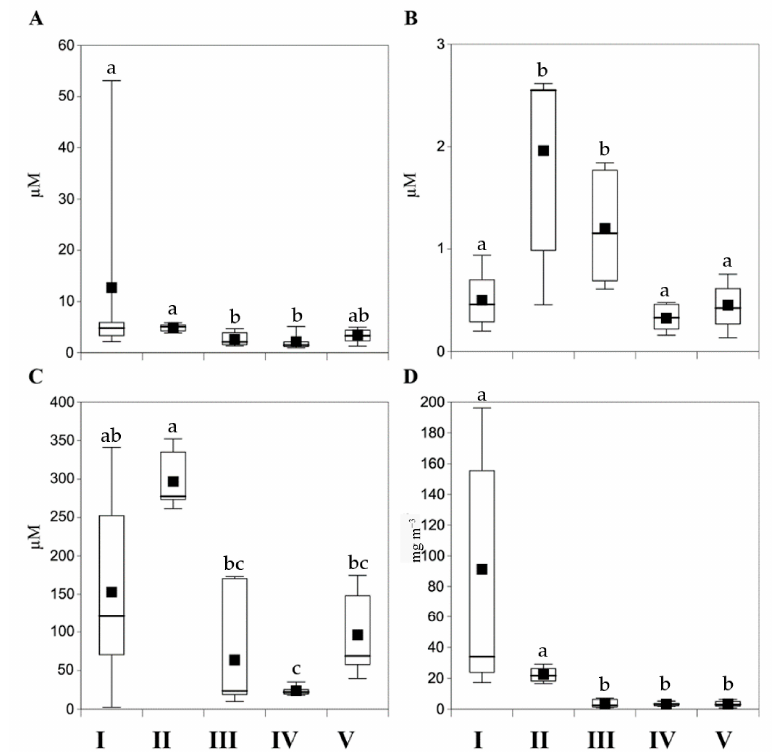
Figure 3. Boxplots depicting seasonal variability of dissolved inorganic nitrogen (DIN) ( A ) reactive phosphorus (PO 4 ) ( B ), reactive silica (SiO 4 ) ( C ), and chlorophyll a (Chla) ( D ) in Santa Giusta Lagoon along the study periods. Five periods were considered: Summer 2018 (I), Autumn (II), Winter (III), Spring (IV) and Summer 2019 (V). Boxplots include the entire series of data for each considered period. Lines represent medians; squares represent means. Bottom of box is the first quartile (Q1); upper part is the third quartile (Q3). Whiskers represent the 90th and 10th percentiles. Different letters indicate significant differences among periods ( p < 0.05).